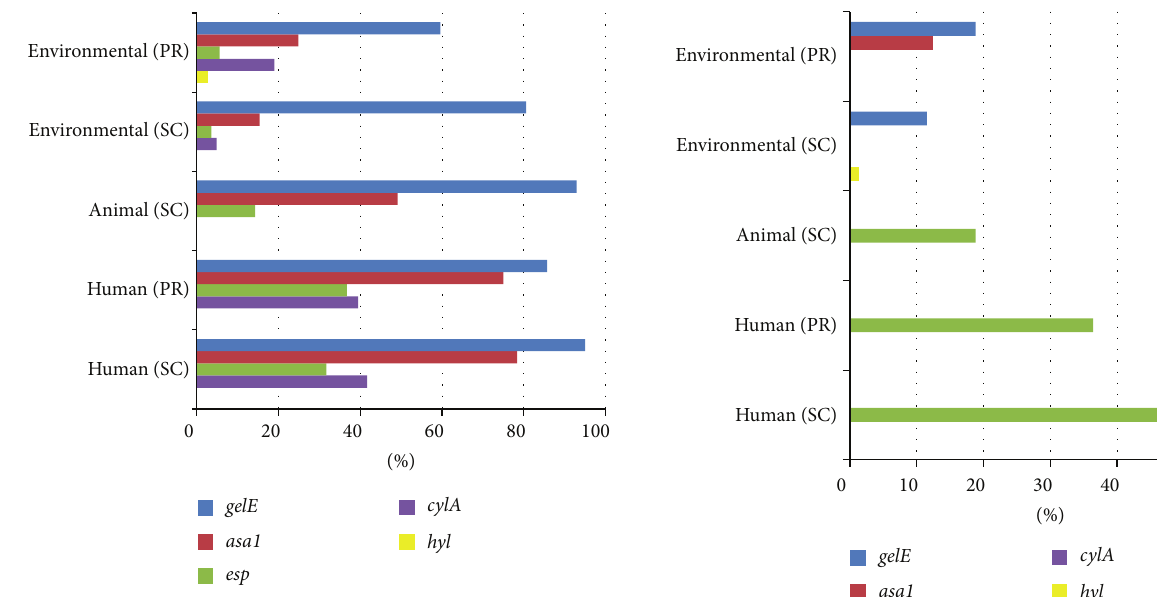
Figure 1: Distribution of virulence factor genes among E. faecalis isolates from environmental, animal, and human sources in Puerto Rico (PR) and Southern California (SC). Figure 2: Distribution of virulence factor genes among E. faecium isolates from environmental, animal, and human sources in Puerto Rico (PR) and Southern California